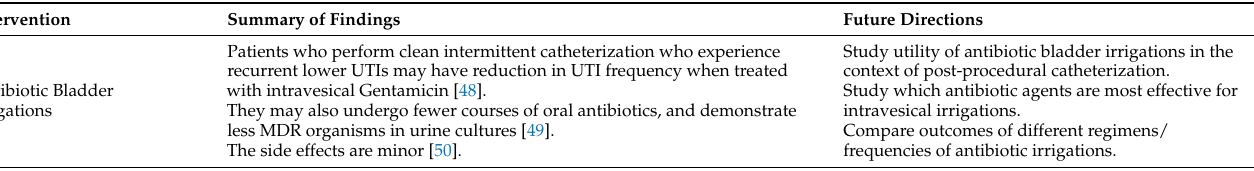
Table 4. Alternative approaches to systemic antimicrobial prophylaxis for the prevention of UTI and